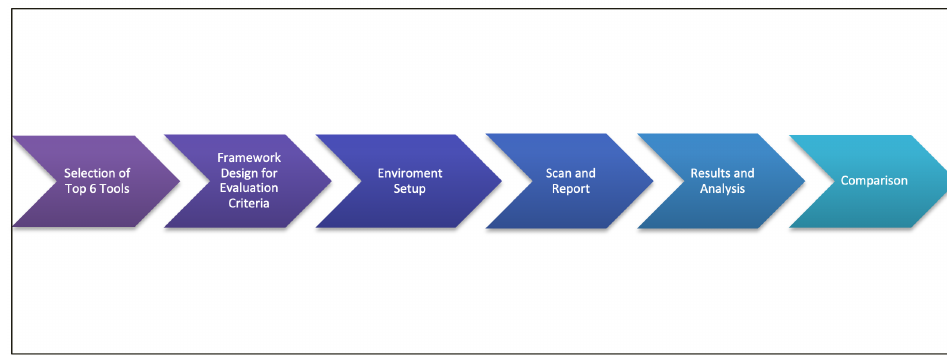
Figure 2. Research Methodology.